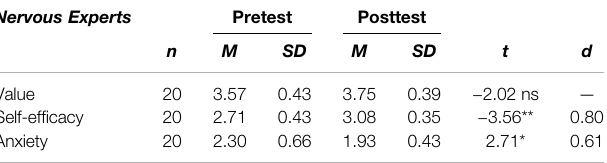
TABLE 4 | Pretest and posttest scores of the nervous experts for the three measures value, self-ef fi cacy and anxiety, and t -test for difference in means.